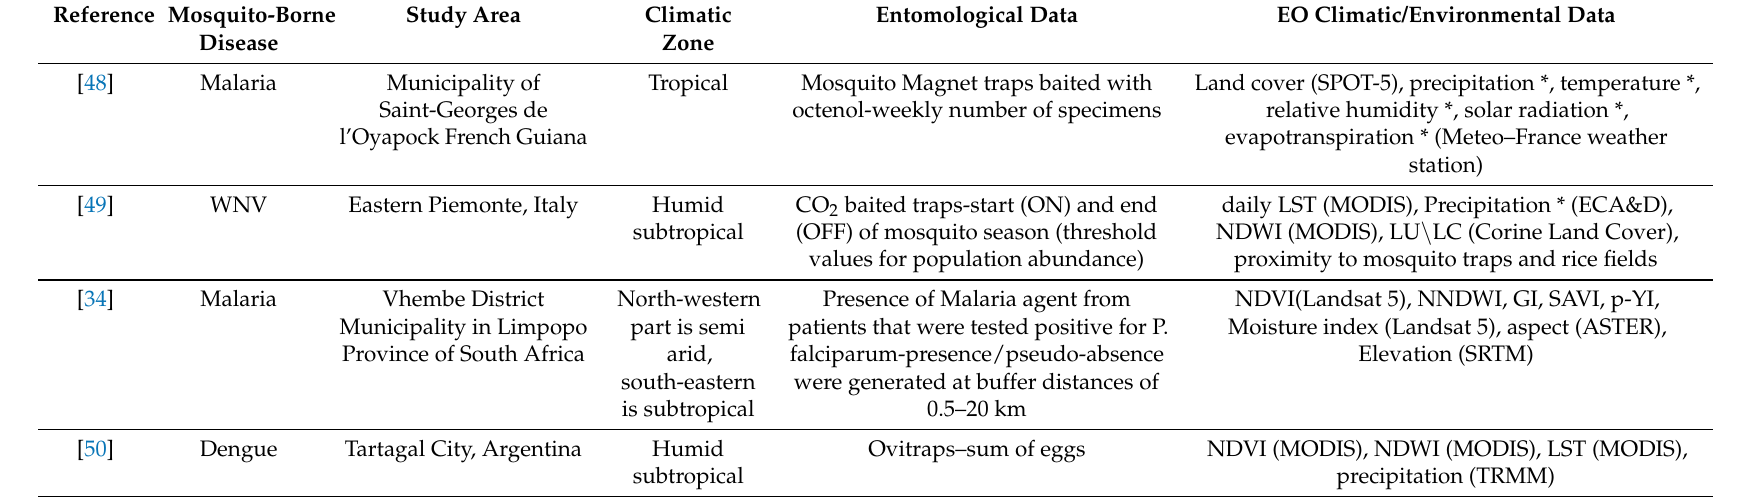
Table A5. Overview of studies that utilized EO derived environmental/climatic variables and entomological data * in situ data. Reference